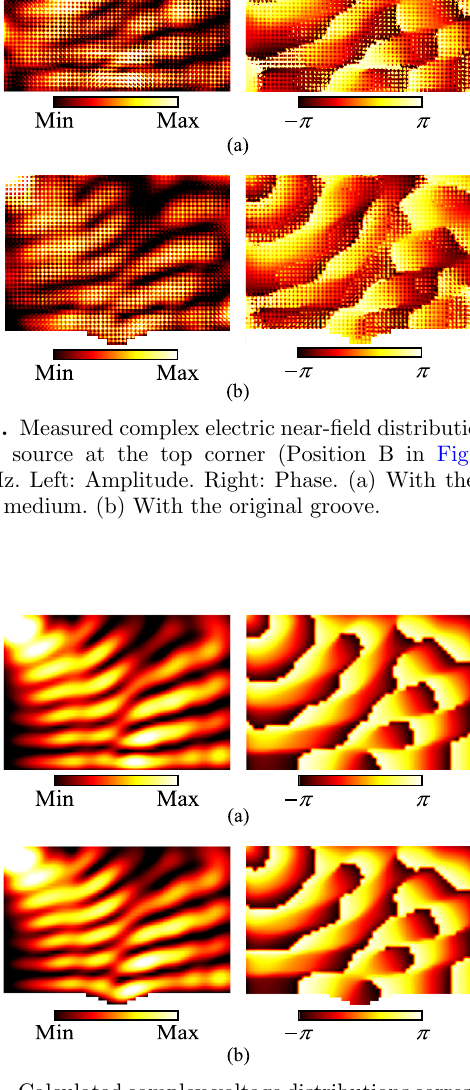
Fig. 27. Calculated complex voltage distributions corresponding to measured results in Figure 26. Left: Amplitude. Right: Phase. (a) With the groove illusion medium. (b) With the original